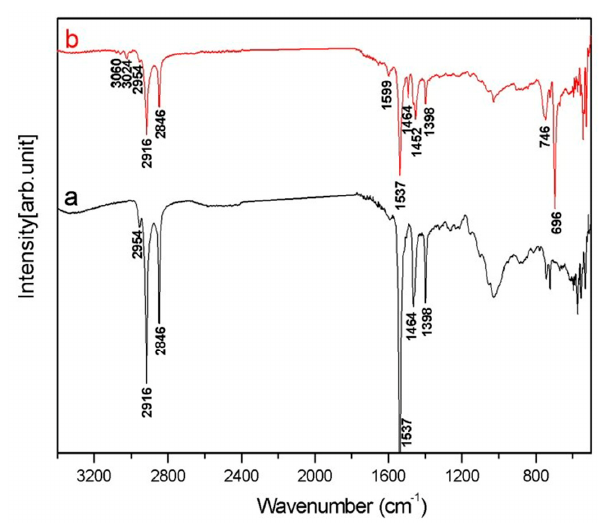
Figure 4. FT-IR spectra of ( a ) wood flour coated with octadecanoic acid modified-nZnO and ( b ) as-prepared superhydrophobic/superoleophilic wood flour.